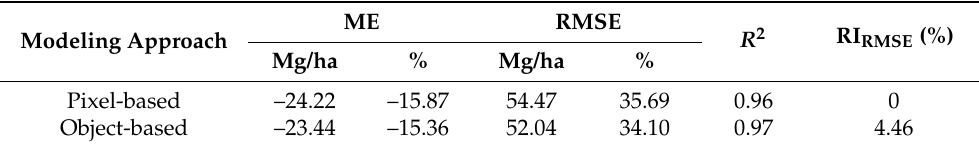
Table 7. Accuracy comparison between pixel- and object-based approach for RF modeling by independent validation data.